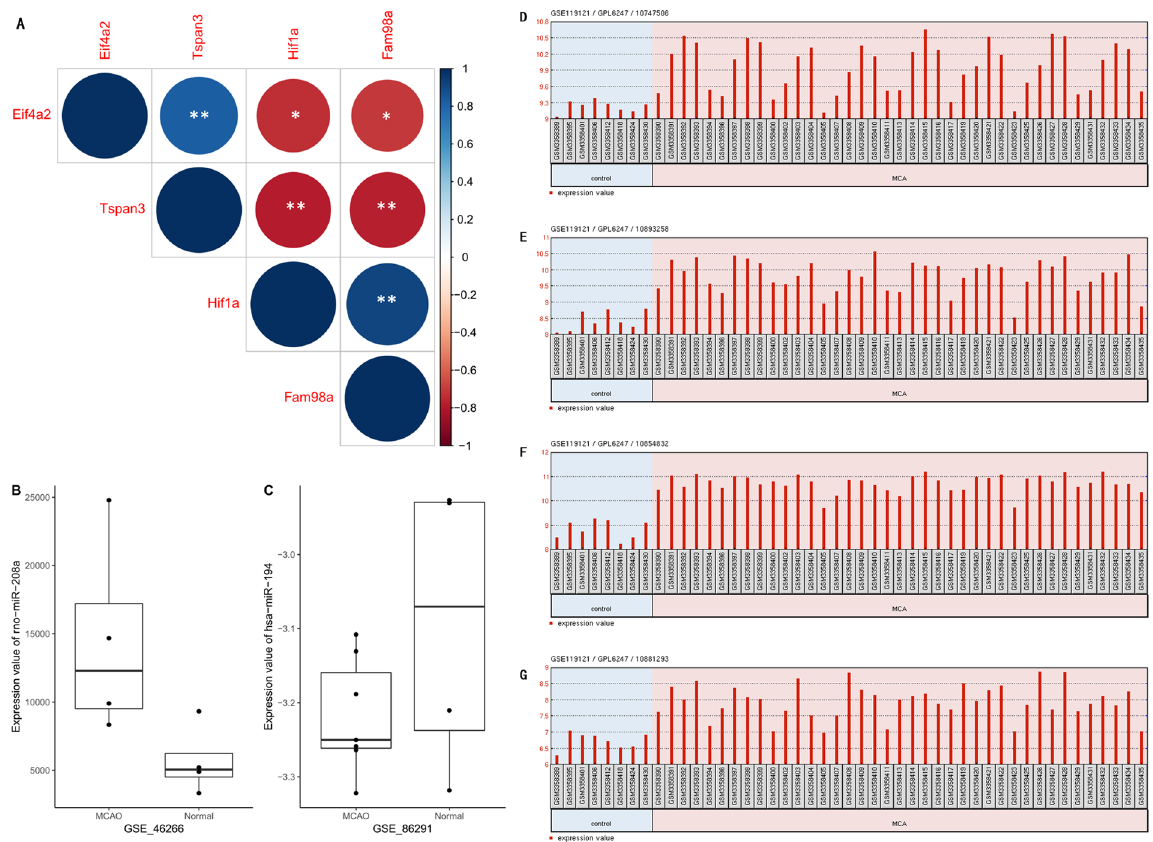
Figure 11. Validation of key genes of ceRNA sub-network in Cerebral Infarction. ( A ) Correlation of Tspan3, Eif4a2 with Hif1a, Fam98a; ( B ) The expression value of rno-miR-208a between MCAO and Normal group in GSE_46266; ( C ) The expression value of rno-miR-194 between MCAO and Normal group in GSE_86291; ( D , E , F , G )The expression value of Stat3, Cd63, H3f3b and Pdpn between MCAO and Normal group in GSE_119121. The red color in A indicate negative correlation while blue positive correlation, size of circle indicates correlation value. * P < 0.05, ** P <